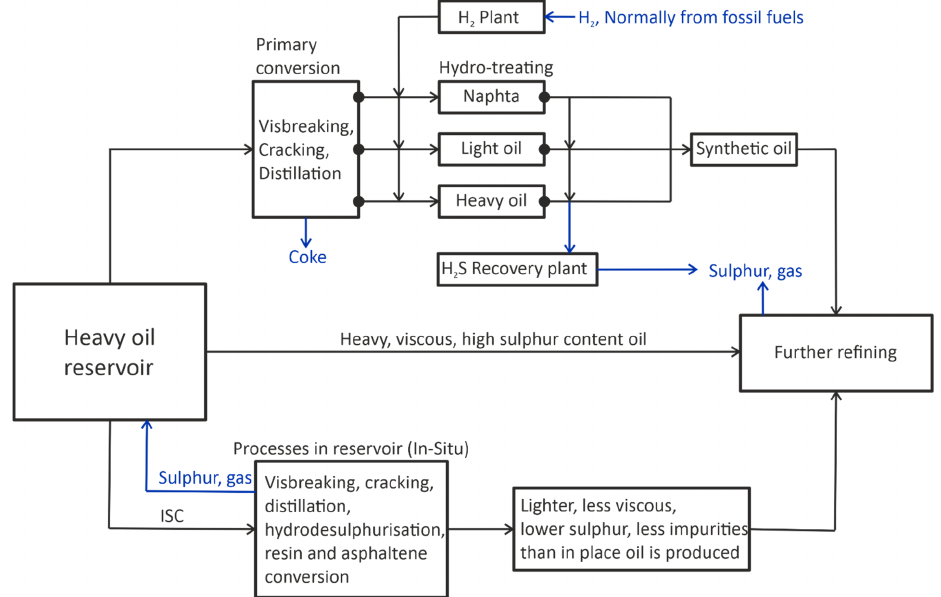
Figure 4. Process of conventional upgrading of heavy oils versus in-situ upgrading, ISU allows for less pollution released in to the atmosphere, and no extra source of hydrogen is required for hydrodesulphurisation, with sulphur and other polluting gases left behind.